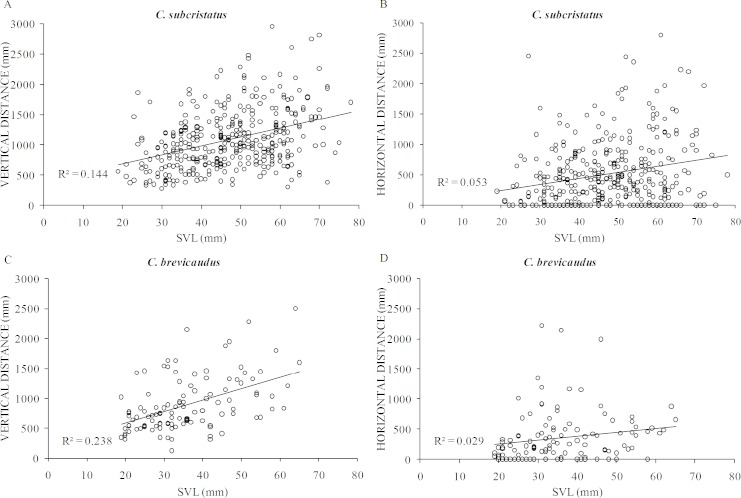
Relationship of body size with vertical distance and horizontal distance.Relationship of body size (snout to vent length—SVL) of individuals belonging to Coryphophylax subcristatus (A–B) and C. brevicaudus (C–D), with vertical distance and horizontal distance. R2 denotes the coefficient of determination.